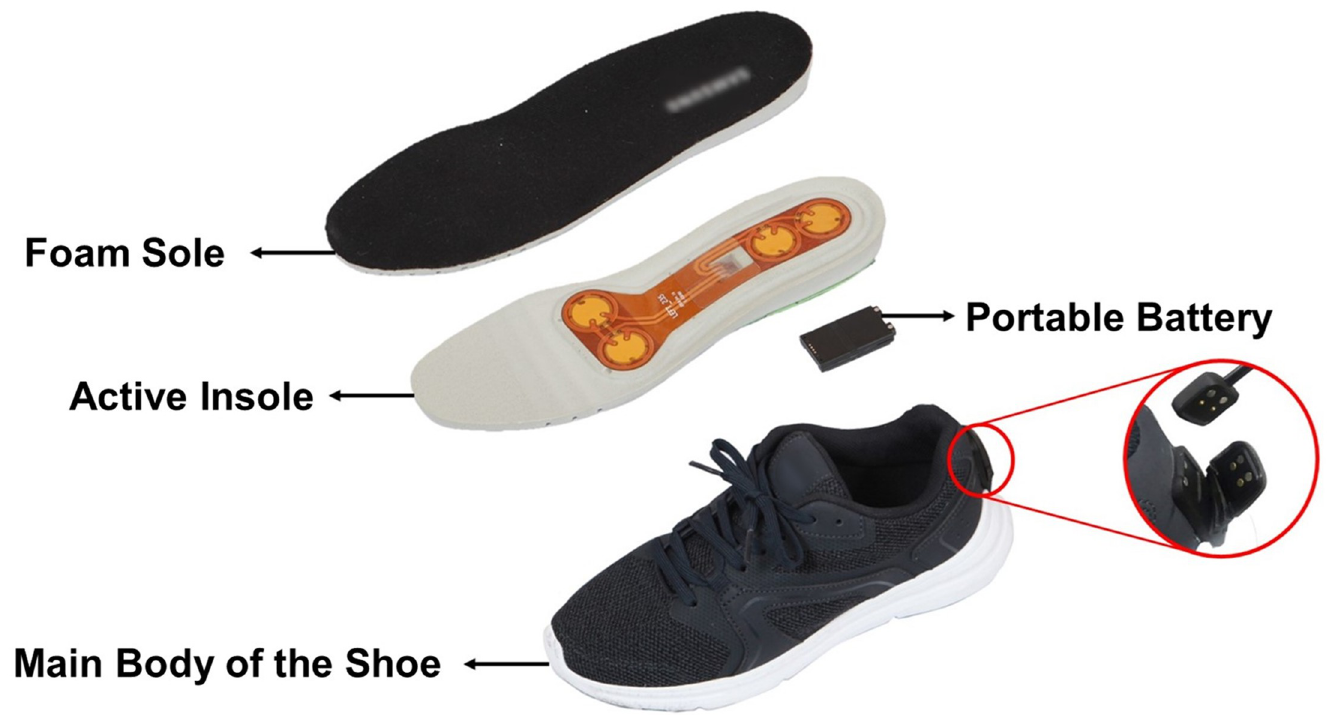
Fig 1. The custom-built shoe with an active insole. The system consisted of a foam sole, an active insole, a portable battery, and the main body. The portable battery could be attached to the bottom of the active insole. Mechanical vibration was applied to the metatarsal head and heel using the actuators in the active insole, which could be placed inside the shoes and connected to the charging port of the shoes. The red circle shows a magnified view of the charging port that can be opened and connected to a custom-made power cable.